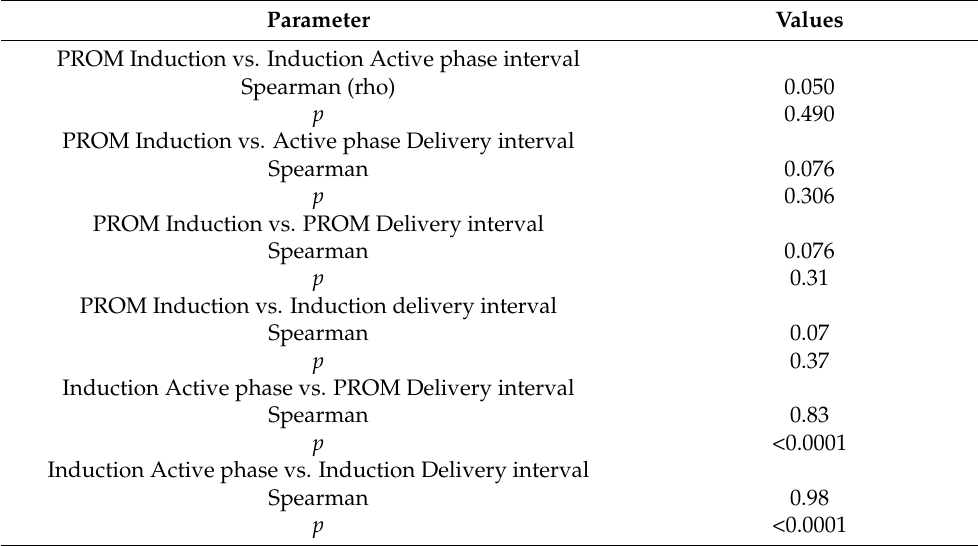
Table 7. Correlation between the individual delivery intervals.